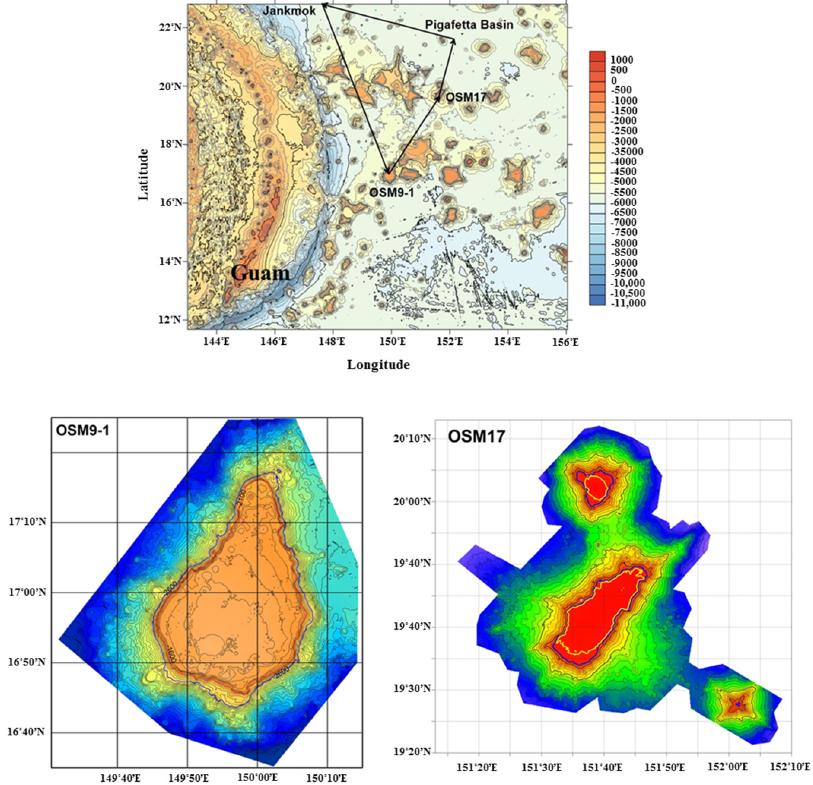
Figure 1. Map of the western Pacific Ocean and geographic distribution of sampling sites. Table 2. Morphometric characters of the two eel specimens collected from the East Mariana Basin, western Pacific Ocean.